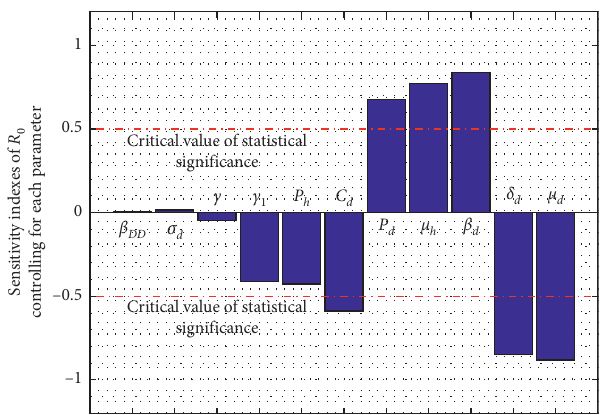
Figure 1: Plot of PRCC of R Table 2: Sensitivity indexes of R